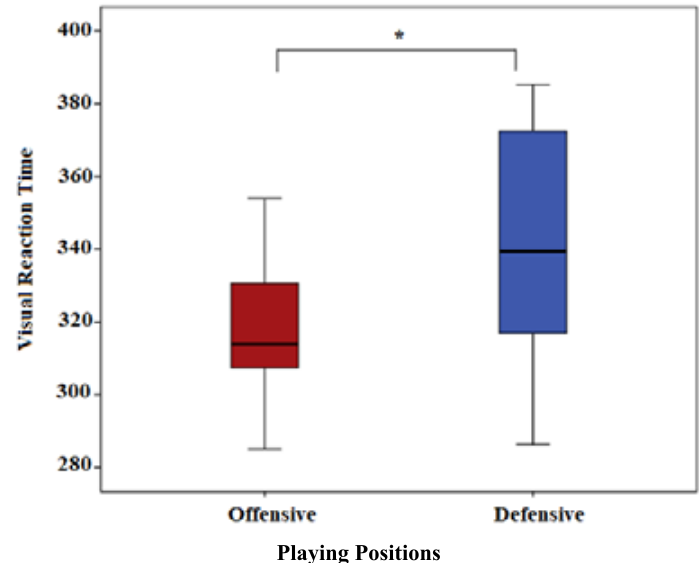
Figure 4. Comparison of Visual Reaction Time (ms) of players according to playing positions